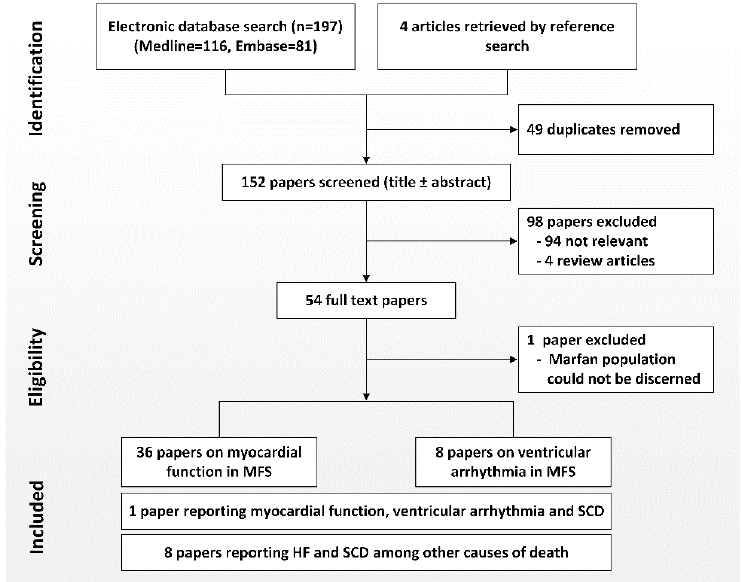
Figure 1. Flow chart of literature search. MFS: Marfan syndrome, SCD: Sudden Cardiac Death, HF: Heart failure.